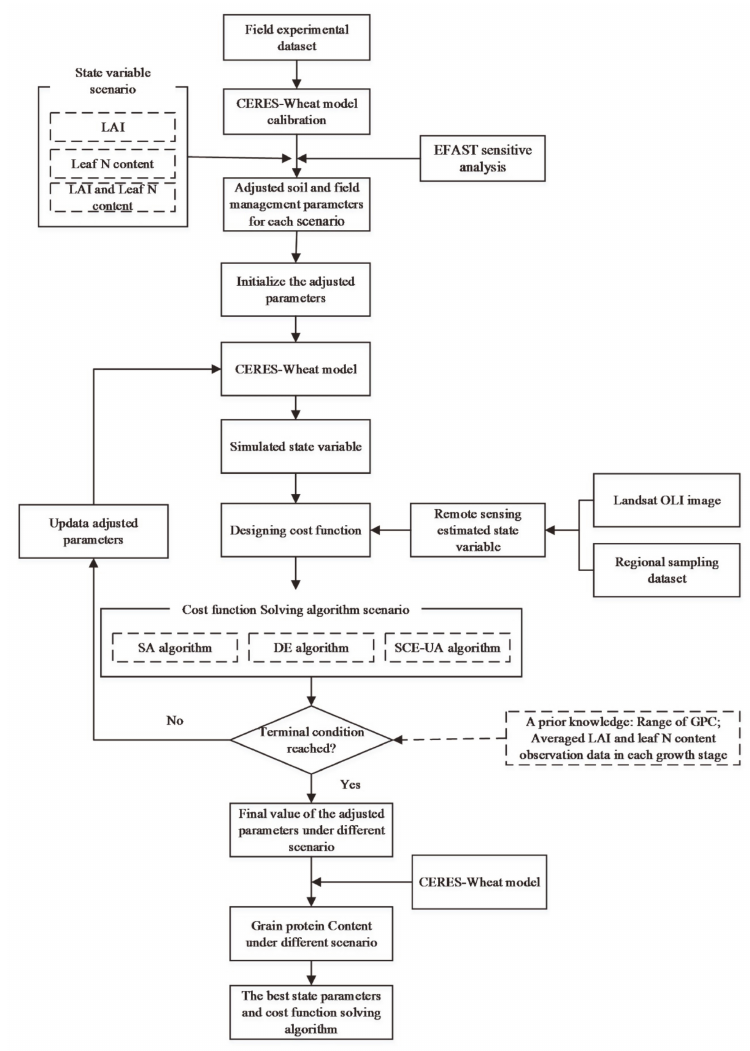
Figure 2. Flowchart for data